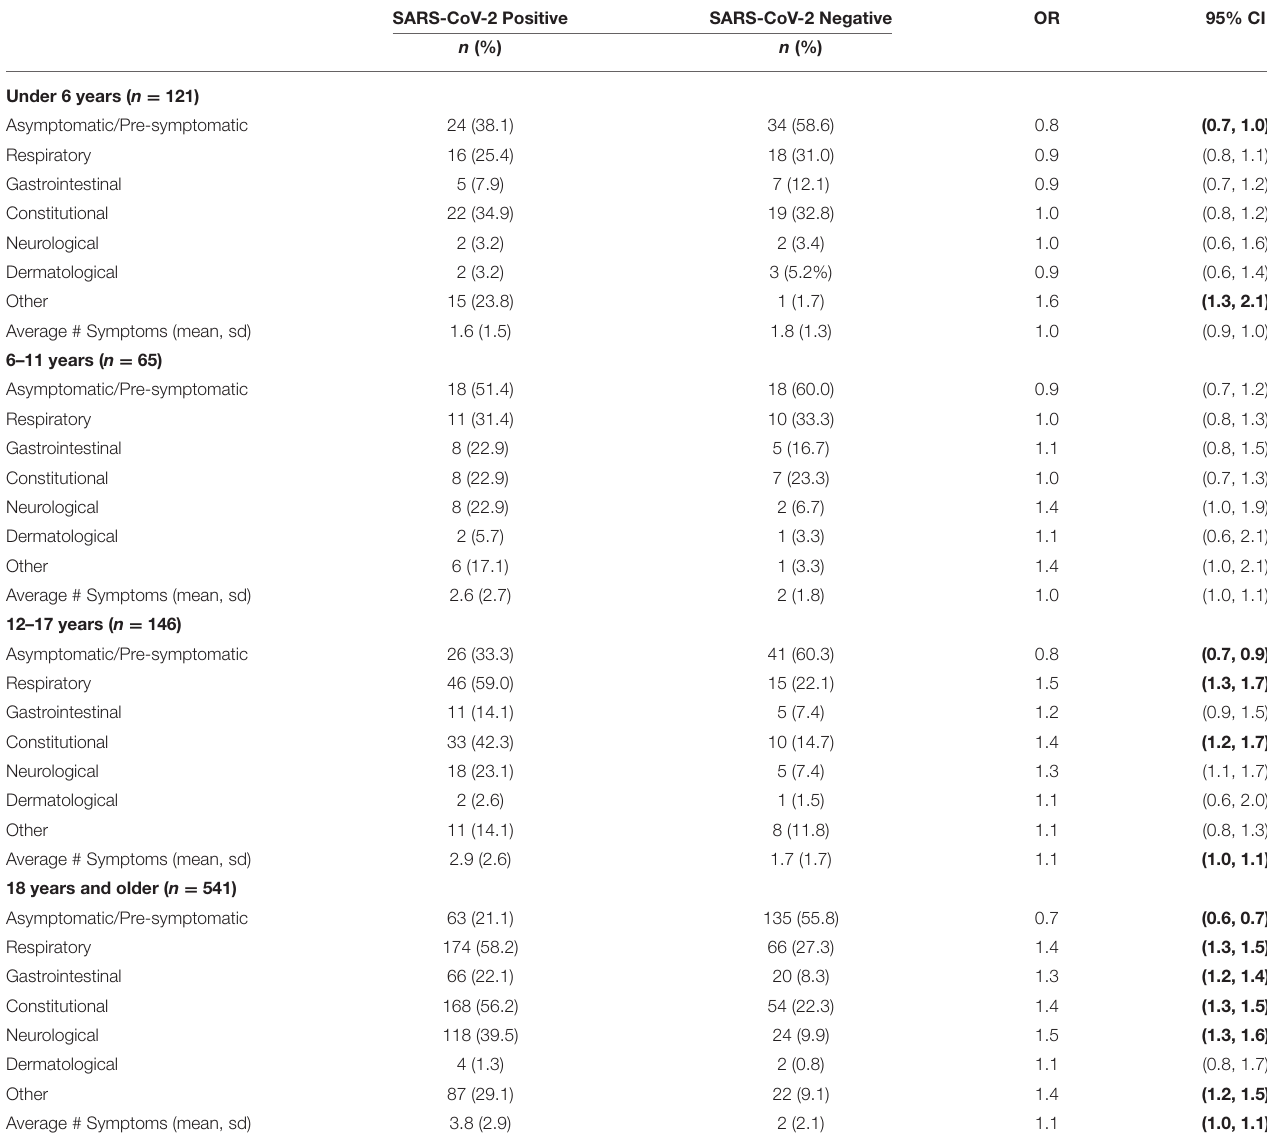
TABLE 5 | Symptoms at time of SARS-CoV-2 testing stratified by age. SARS-CoV-2 Positive SARS-CoV-2